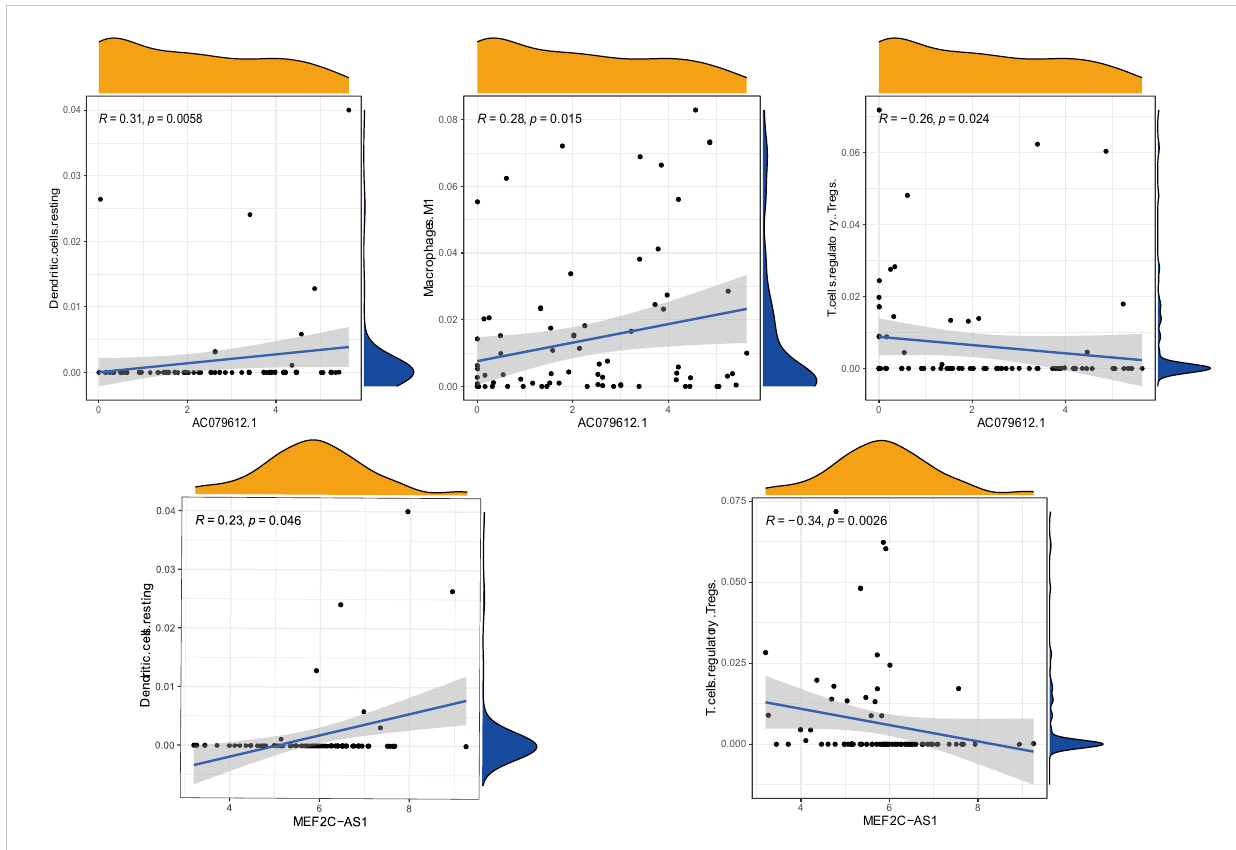
FIGURE 10 Correlation between immune cells (Dendritic.cells, T.cells.regulatory, Macrophages.M1, T.cells.regulatory, and Dendritic.cells) and target genes (AC079612.1 and